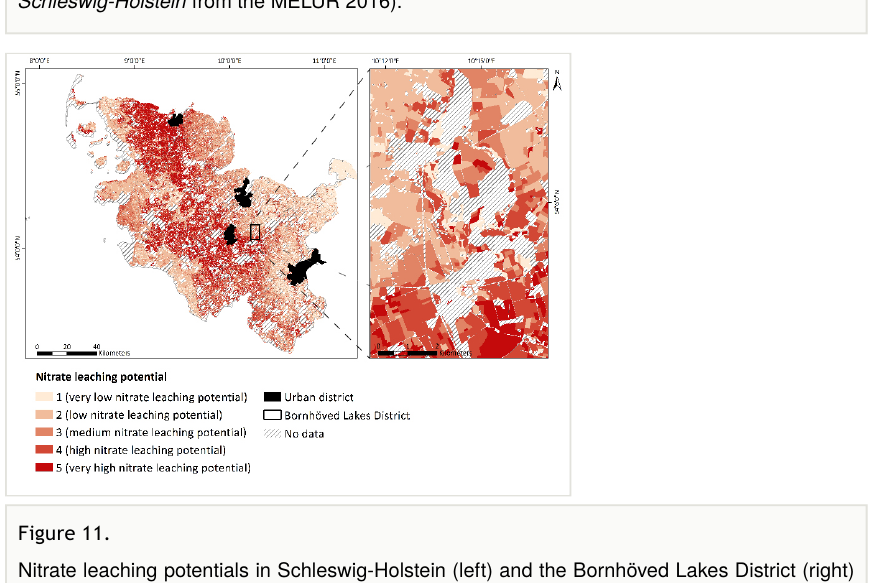
Low nitrate leaching potentials can be found along both coastlines of Schleswig-Holstein (Fig. 11). Lowest potentials agglomerate at the central part of the Baltic Sea coastline. High potentials are located in the hinterland, increasing from south to north. Thus, the area with high potentials coincides with the spatial extent of the Geest . In accordance with this pattern, in the Bornhöved Lakes District, the potential decreases from south to north (Fig. 11).